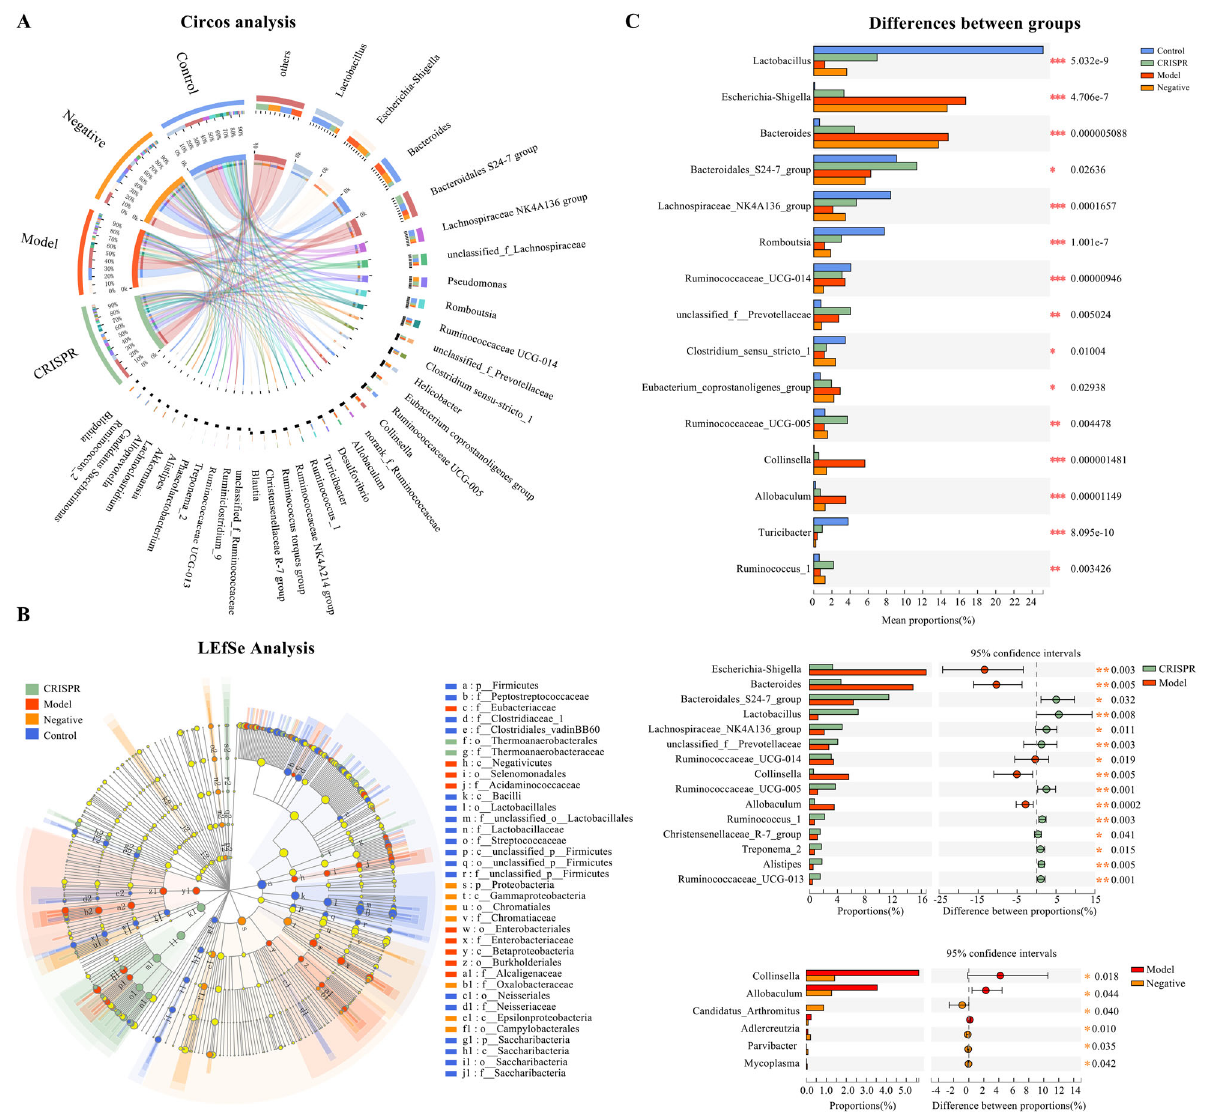
Fig. 6 Species that signi fi cantly differ between the CRISPR group, the model group, and the control. A Circos analysis presented the distribution of the dominant species in the CRISPR group, the model group, and the control. B Kruskal – Wallis H test showed the abundance of several species were signi fi cantly different between the CRISPR group, the model group, and the control. Lactobacillus was signi fi cantly enriched in the control, Bacteroidales S24-7 group was high in the CRISPR group, and species Escherichia – Shigella , Bacteroides , and Collinsella were dominant in the model group. C The LEfSe results were aligned with those of the signi fi cant differences analysis between groups. Fecal samples were collected from 32 rats with CCl 4 -induced liver fi brosis and 20 normal rat (the control). Fecal samples collected before injection of RSPO4-CRISPR were noted as the model group, and samples collected after the injection of RSPO4-CRISPR were noted as the CRISRP